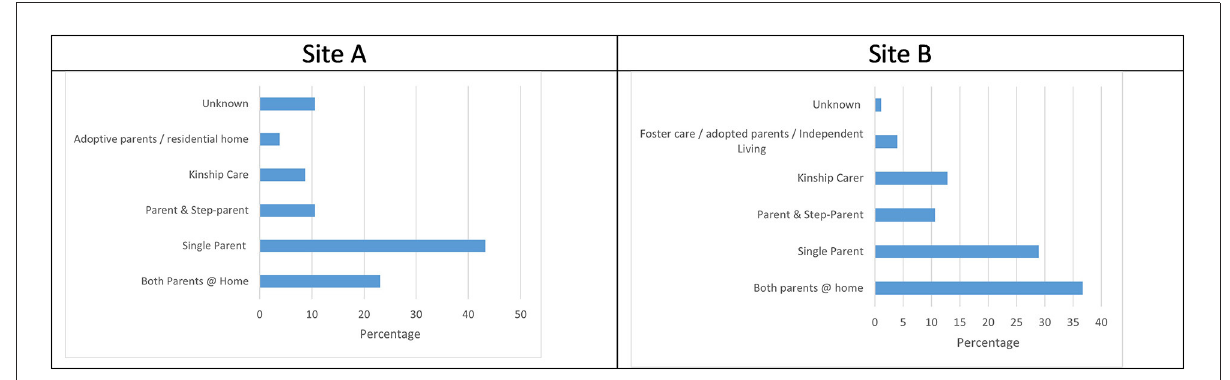
FIGURE2 (A,B) Family composition.